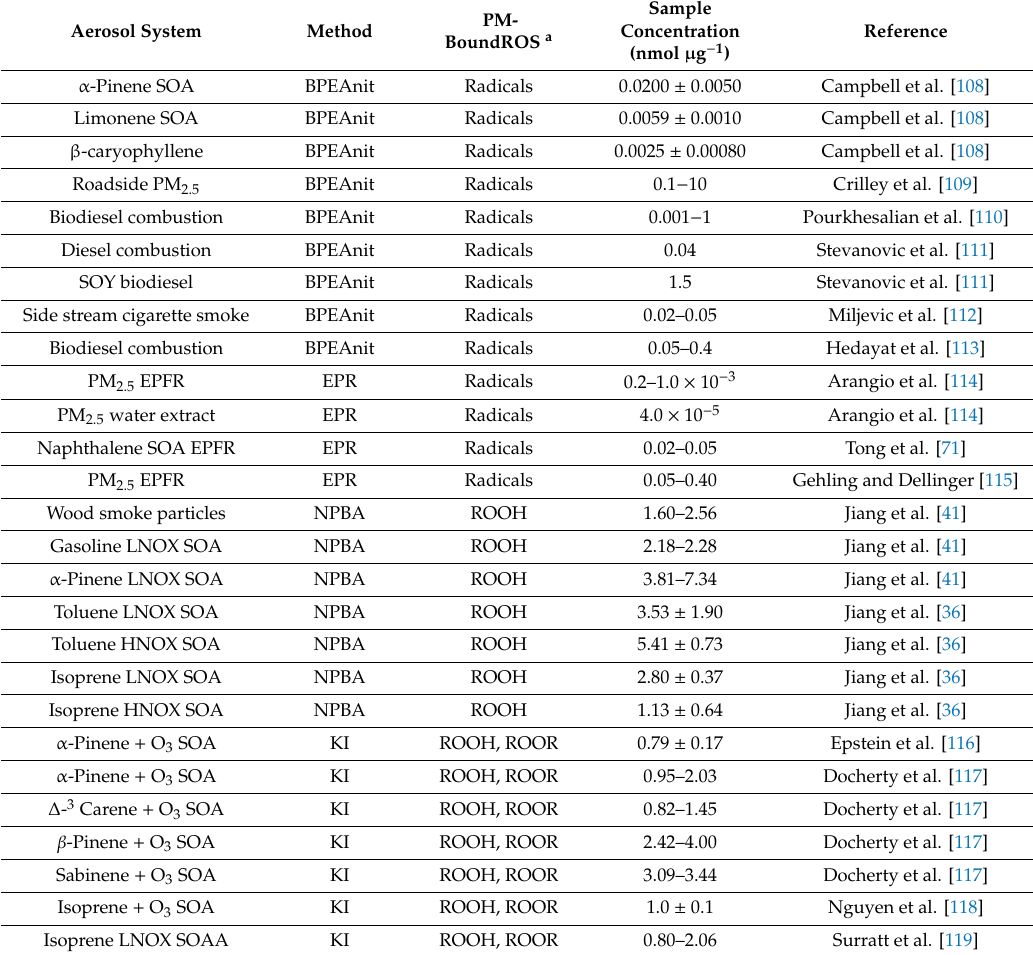
Table 2. PM-bound reactive oxygen species (ROS) in various aerosol